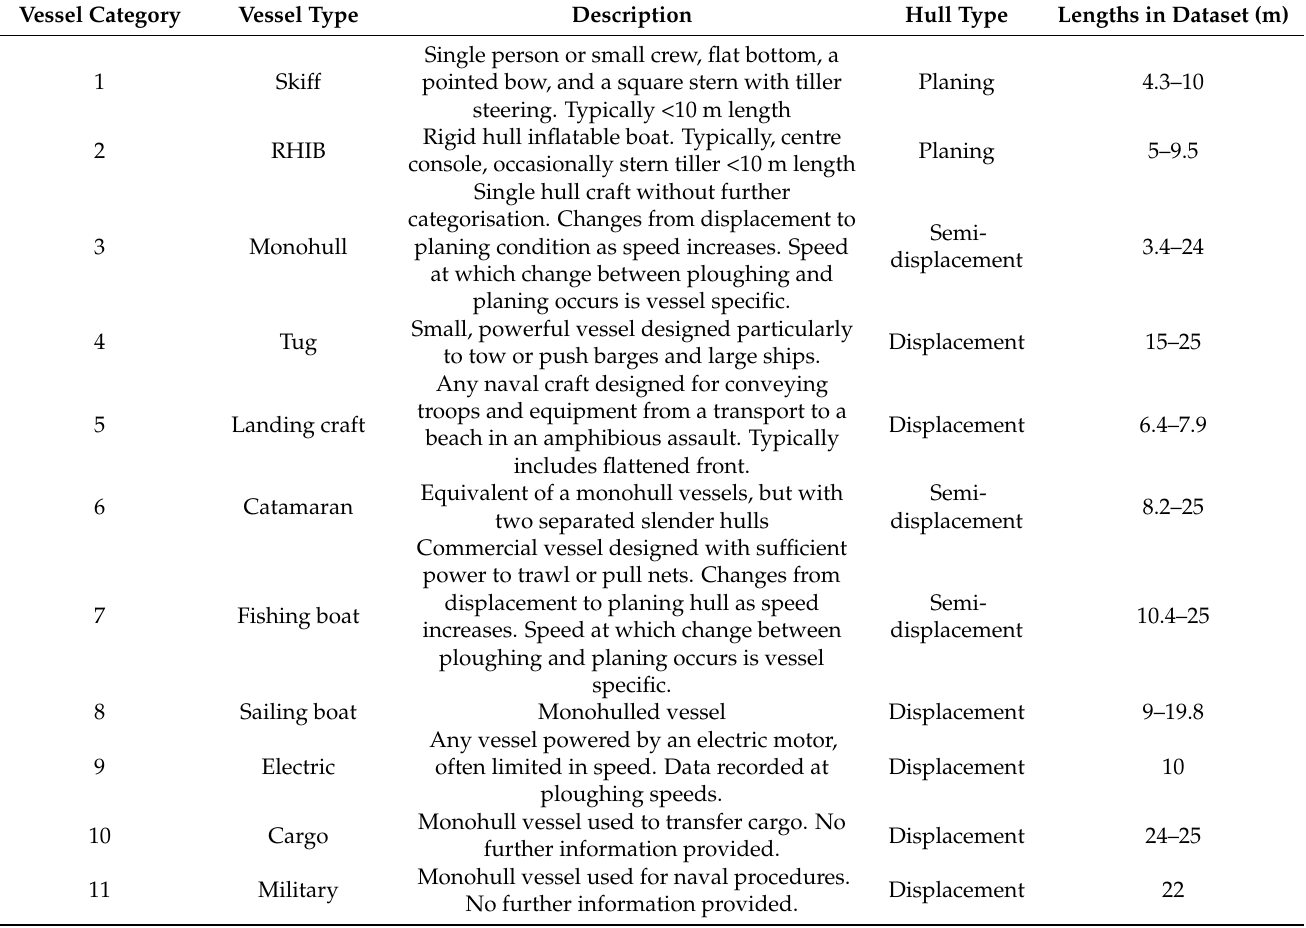
Table 1. Categories of small vessels and their descriptions included in the